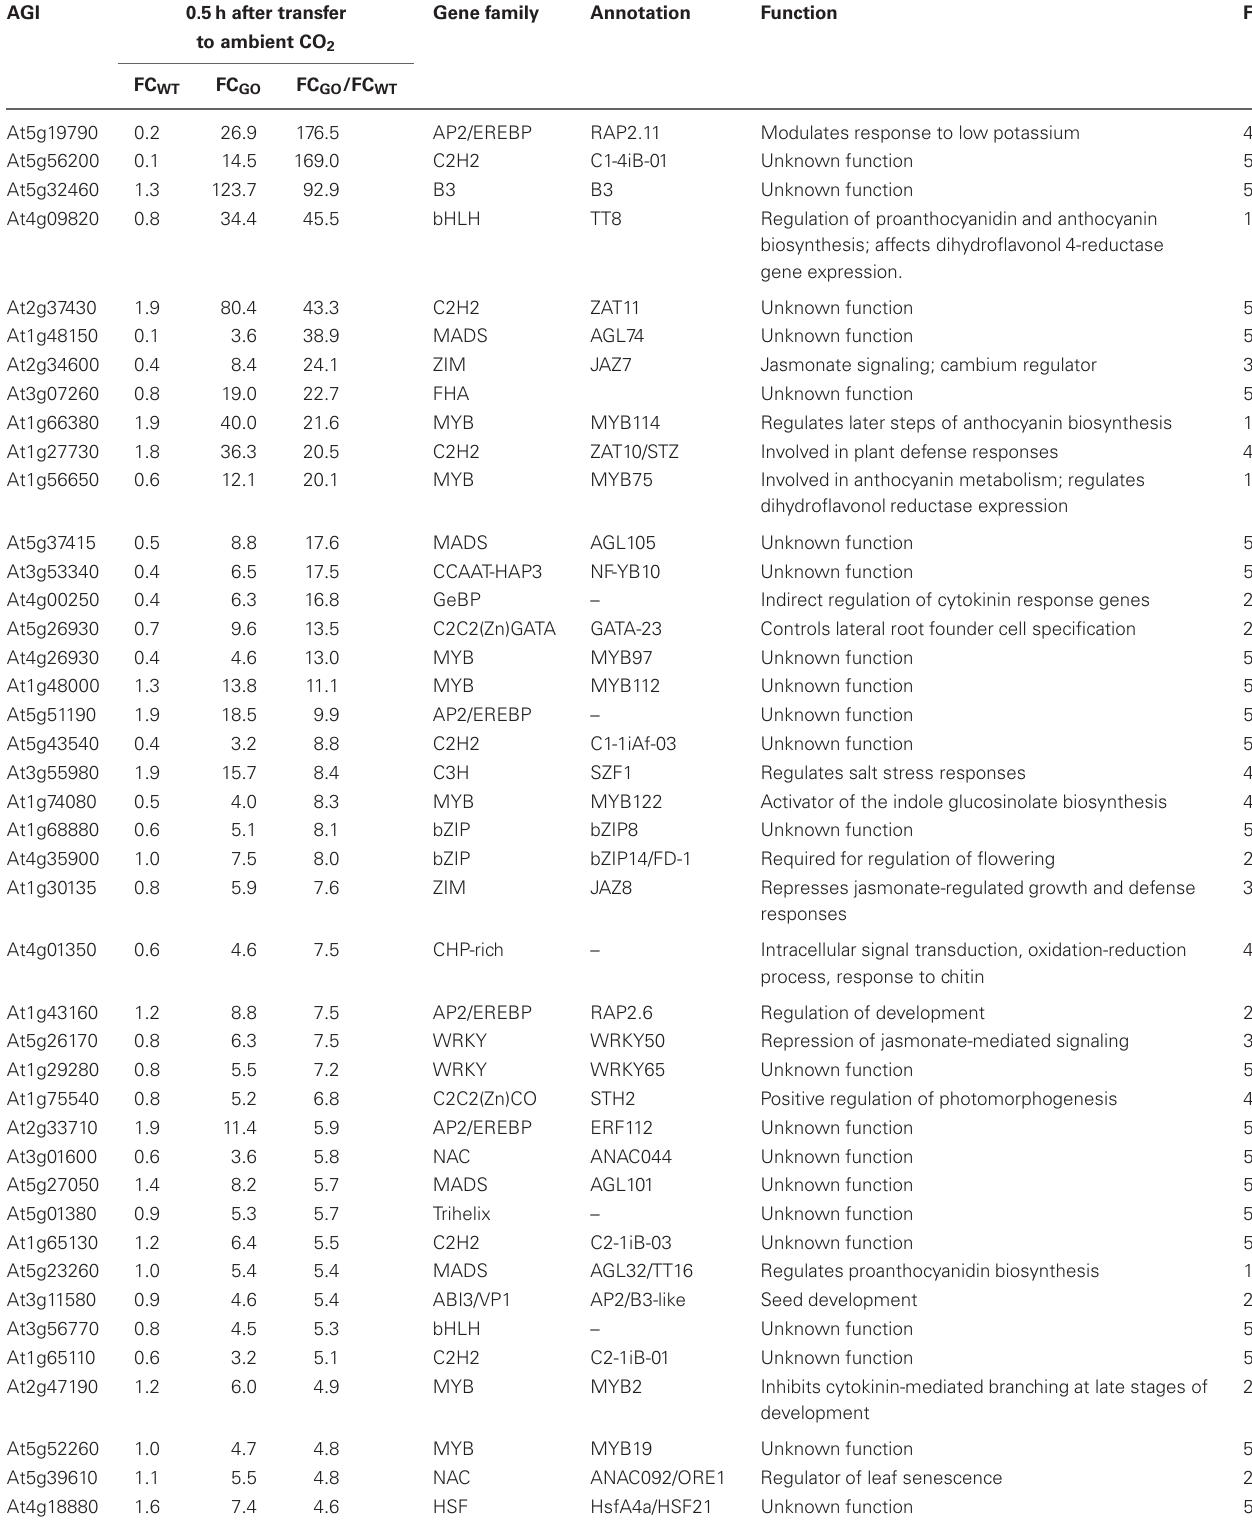
Table 4 | Transcription factors the expression of which was enhanced by more than 3-fold in GO plants, but less than 2-fold in wild-type plants 0.5h after shifting plants grown at high CO 2 concentration to ambient CO 2